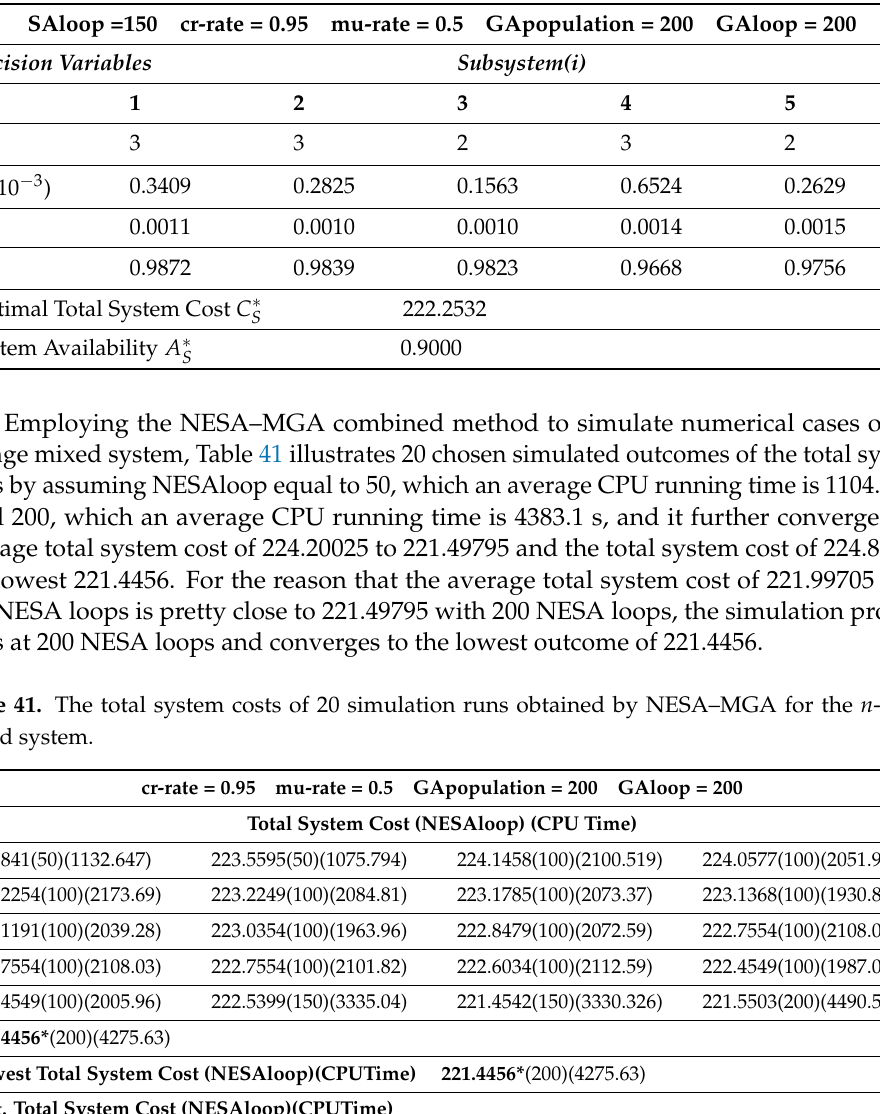
Table 40. Optimal Solutions obtained by SA–MGA for the for the n -stage mixed system.